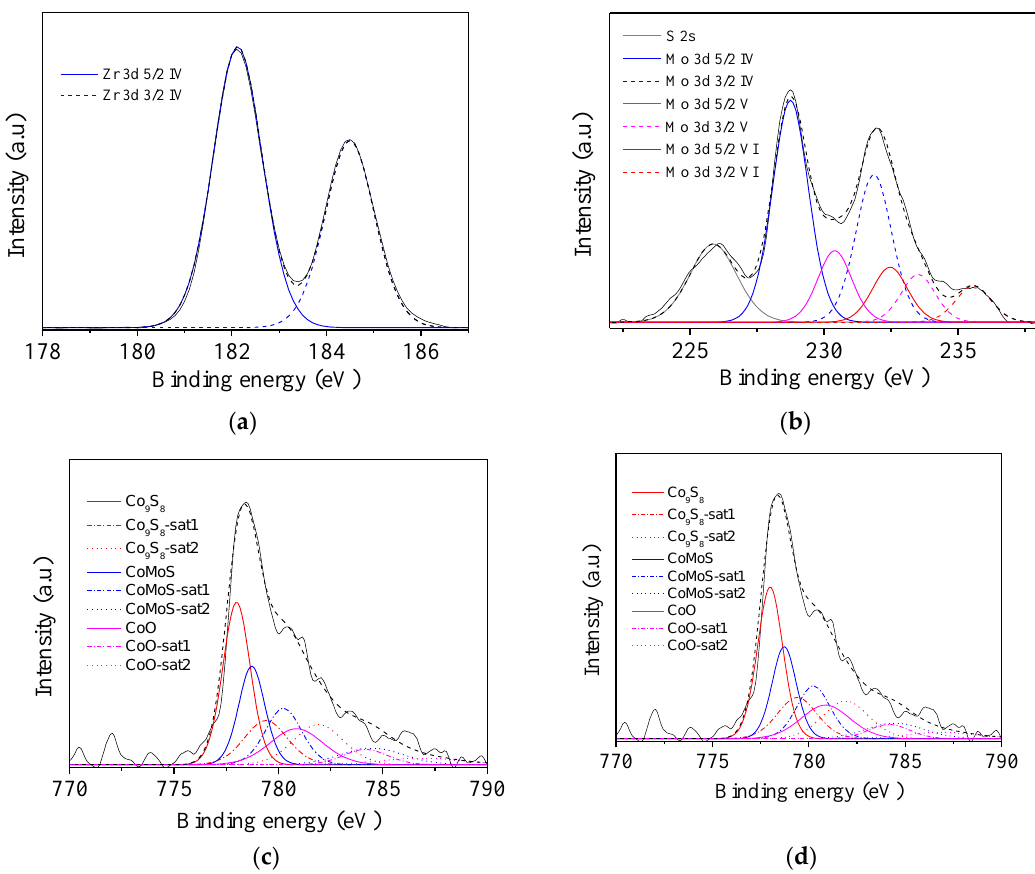
Figure 3. Zr 3d ( a ), Mo 3d ( b ), Co 2p ( c ), and S 2p ( d ) X-ray photoelectron spectroscopy (XPS) spectra of the CoMoS/ ZrO 2 catalyst. Table 1. Percentage obtained by XPS analysis of the phases formed after sulfidation.